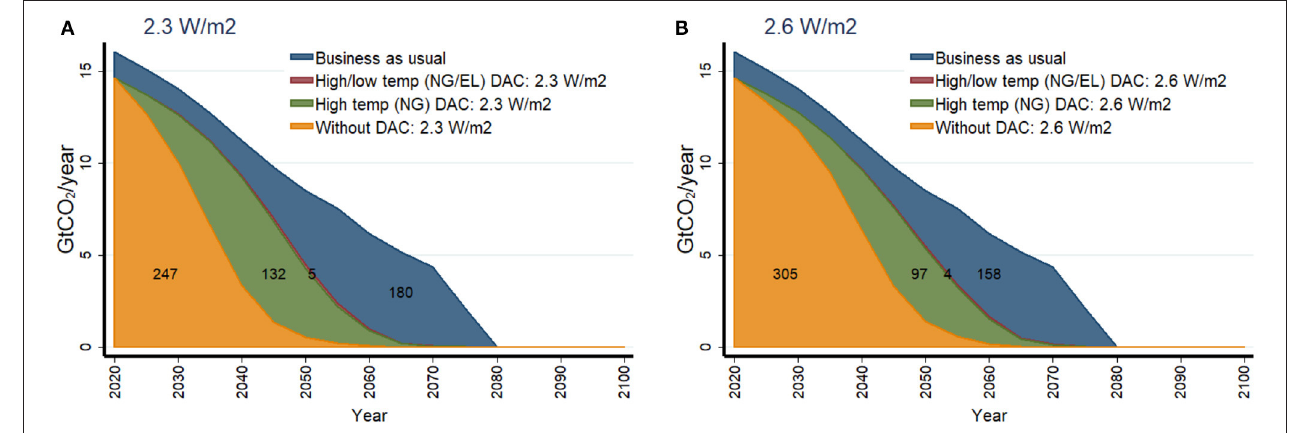
FIGURE 7 | The effects of DAC availability on the CO 2 emissions from the existing power plants in the global power sector. The emissions in the absence of climate policy is shown in “Business as usual” scenario. The scenario “Without DAC” includes only BECCS and AR, the scenario “High temp (NG) DAC” includes a high temperature natural gas-based DAC in addition to BECCS and AR, and the scenario “High/low temp (NG/EL) DAC” includes three types of DAC (high temperature natural gas-based DAC, high temperature electricity-based DAC and low temperature electricity-based DAC) in addition to BECCS and AR. The left panel (A) shows the climate mitigation goal of limiting the total radiative forcing to 2.3 W/m 2 by year 2100 and the right panel (B) shows the climate mitigation goal of limiting the total radiative forcing to 2.6 W/m 2 by year 2100. The cumulative CO 2 emissions from the existing power plants are 564 Gt in the “Business as Usual” scenario. In climate mitigation scenario of 2.3 W/m 2 total radiative forcing, the cumulative emissions are 247, 379, and 384 Gt in the “Without DAC,” “High temp (NG) DAC” and “High/low temp (NG/EL) DAC” scenarios, respectively. In climate mitigation scenario of 2.6 W/m 2 total radiative forcing, the cumulative emissions are 305, 402, and 406 Gt in the “Without DAC,” “High temp (NG) DAC” and “High/low temp (NG/EL) DAC” scenarios, respectively. The numbers on the plot denote the difference in cumulative emissions between adjacent